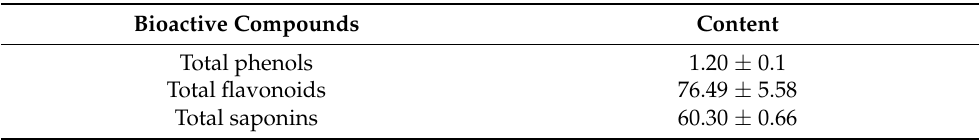
Table 4. The contents of TP, TF, and TS in Gonostegia hirta (mg/g DW). Bioactive